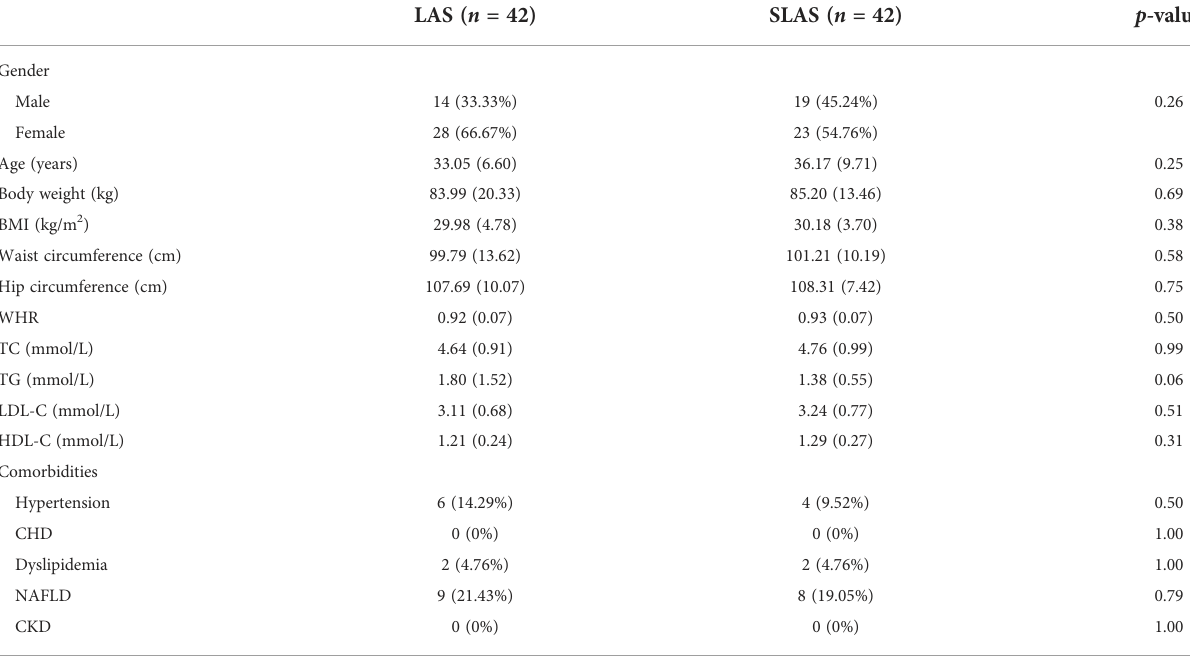
TABLE 2 Baseline characteristics of the intention-to-treat (ITT) population.